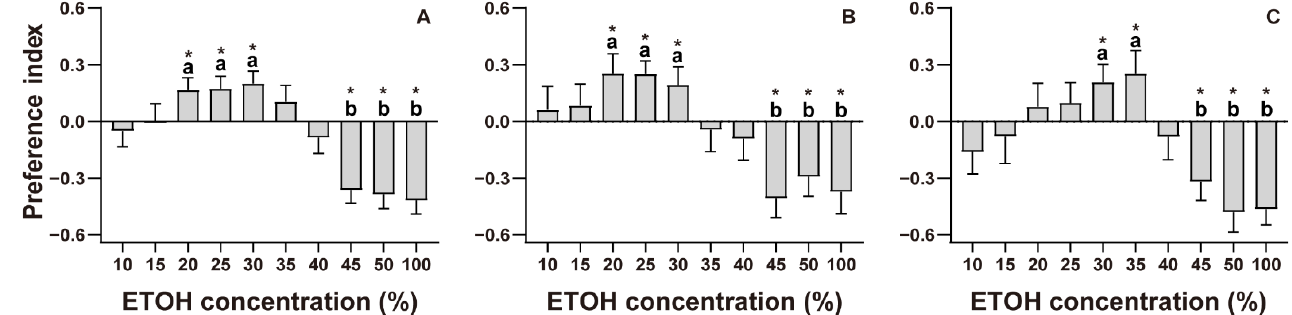
Figure 2. Ethanol (ETOH) preference of male and female Myrmarachne gisti, showing ( A ) preference index ( PI ) for both genders (females: N = 325; males: N = 315), ( B ) PI for females, and ( C ) PI for males. ‘ * ’ indicates a significant difference from 0 ( p < 0.05). One-way analysis of variance (ANOVA) and Student–Newman–Keulsa tests were used for multiple comparisons. Significant differences between the groups are indicated with letters.